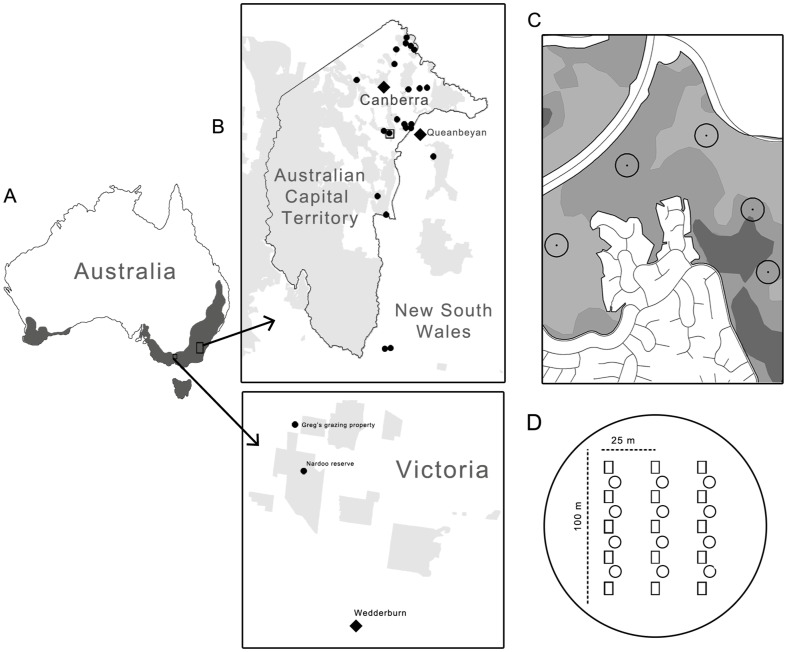
Study Design.a) The distribution of temperate grassland and grassy woodlands (grey) across Australia. Selected study regions are shown (black outline) and expanded in b) location of study sites within south-eastern NSW and central Victoria, with protected areas shown in grey, sites shown as black dots and major towns as large black diamonds, c) an example of stratified random placement of study plots within a study site showing open woodland (light grey), woodland (grey) and open forest (dark grey) canopy types, and d) the layout of tiles (box) and circular survey disks (circle) within the study plot.